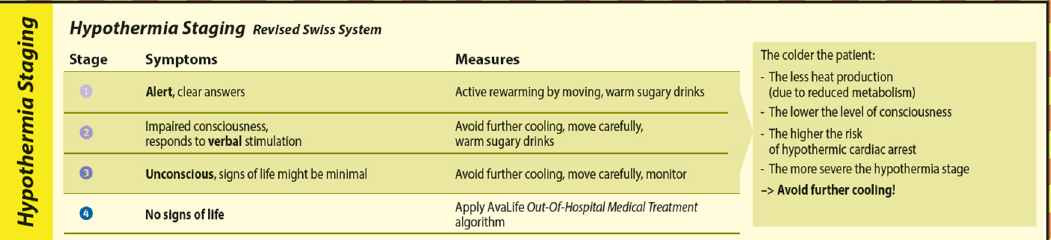
Figure 10. The Hypothermia Staging module of AvaLife.